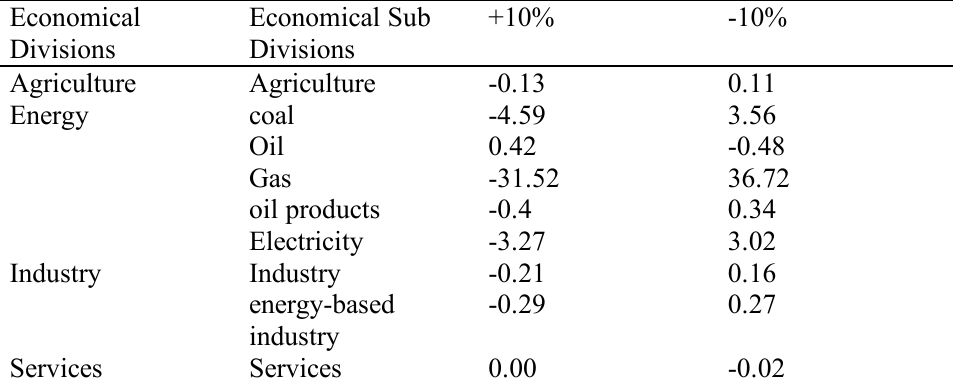
Table 1. The Carbon Footprint Situation on Import of Various Economical Divisions